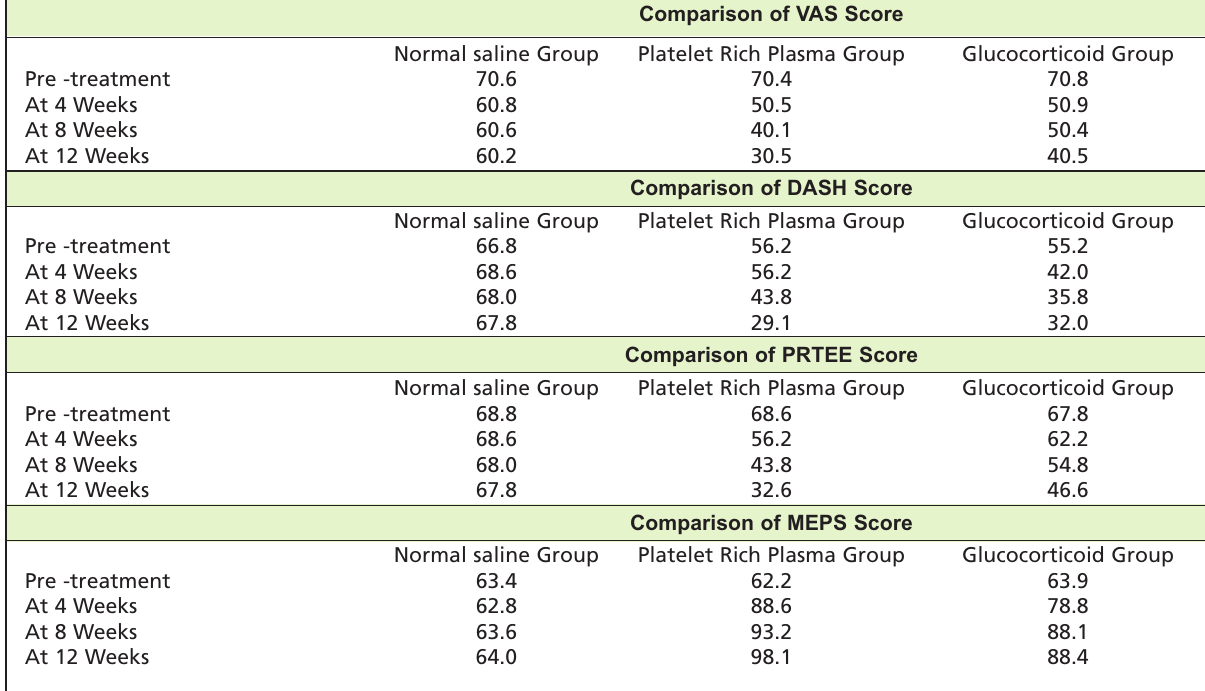
Comparative evaluation of different functional scores with different modalities (Pre and Post infiltration) Table IV: